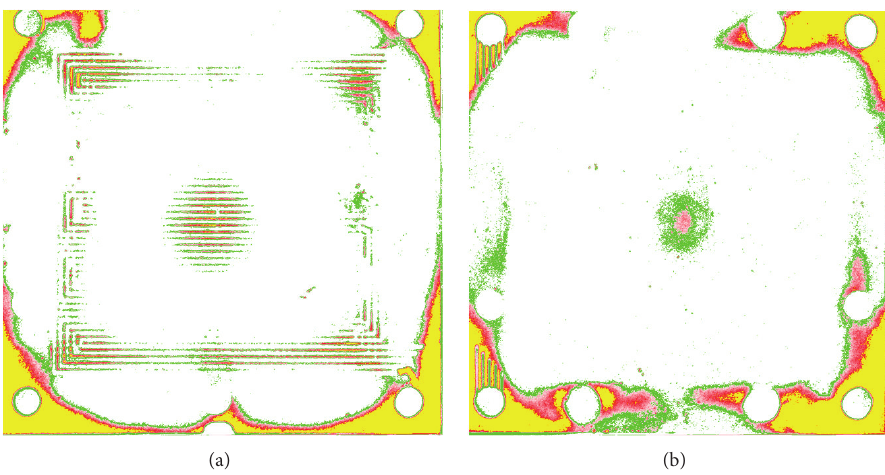
Figure 6: Contact pressure distribution (MPa) between (a) BPP and end plate and (b) two end plates.